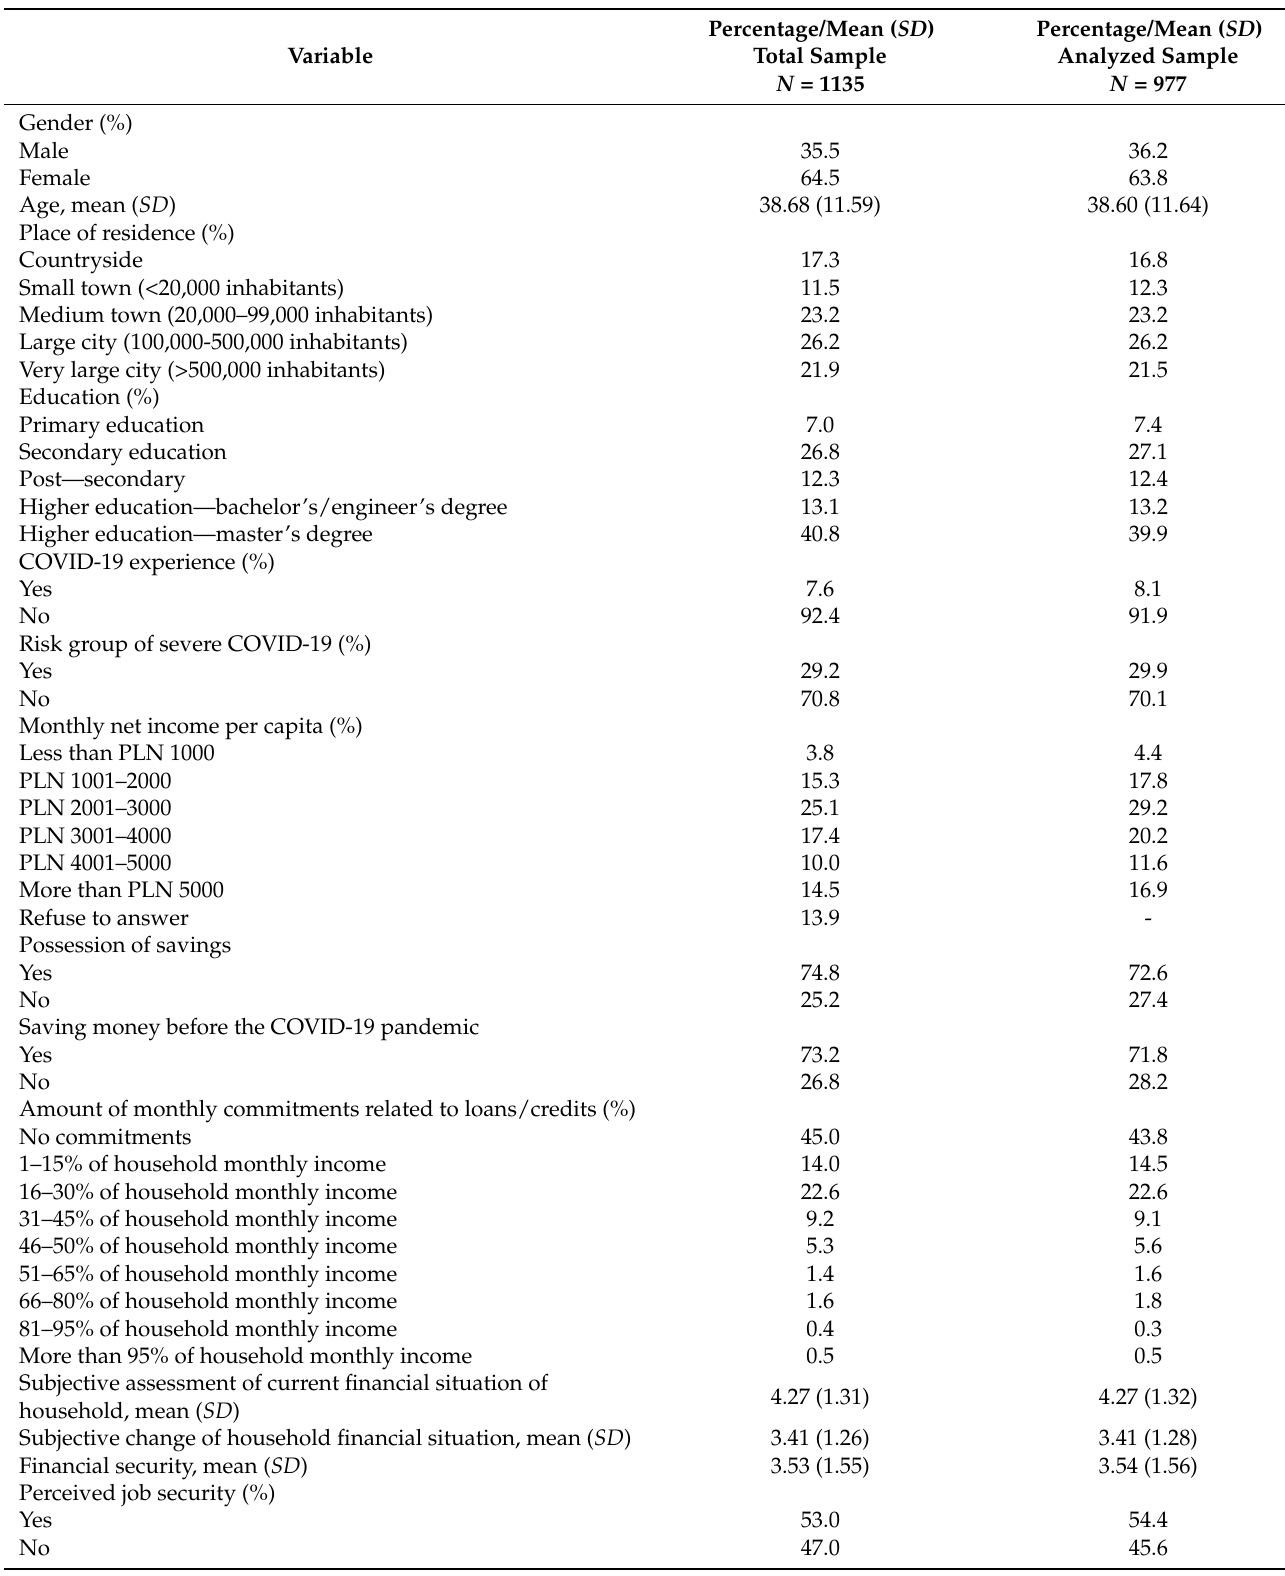
Table A1. Descriptive statistics for the analyzed